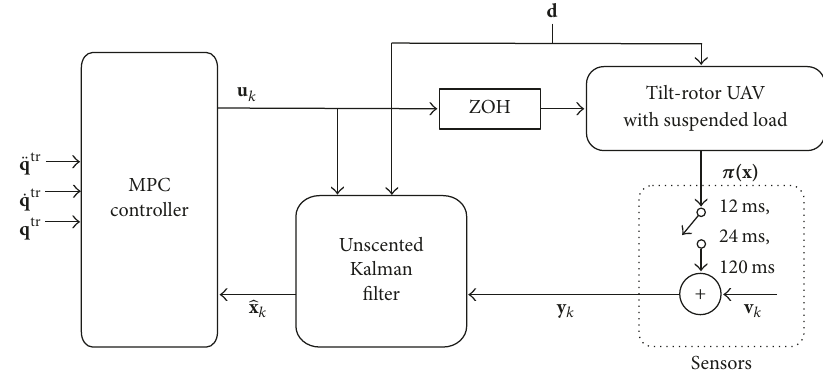
Figure 4: The proposed control and state estimation